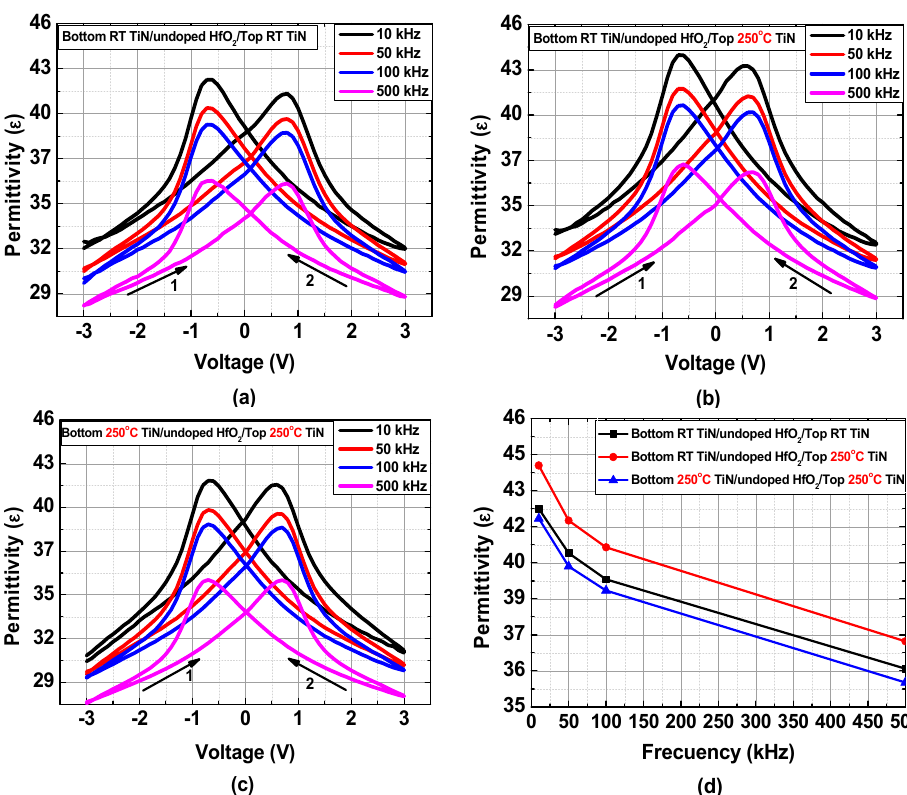
Figure 3. Frequency–dependent permittivity–voltage characteristics of MFM capacitors fabricated with different deposition temperatures for TiN electrodes. ( a ) Top and bottom electrodes deposited at room temperature, ( b ) bottom electrode at room temperature and top electrode at 250 °C , and ( c ) top and bottom electrodes at 250 °C. ( d ) Comparison of the maximum permittivity values for devices ( a , b, and c ) as a function of measurement frequency.